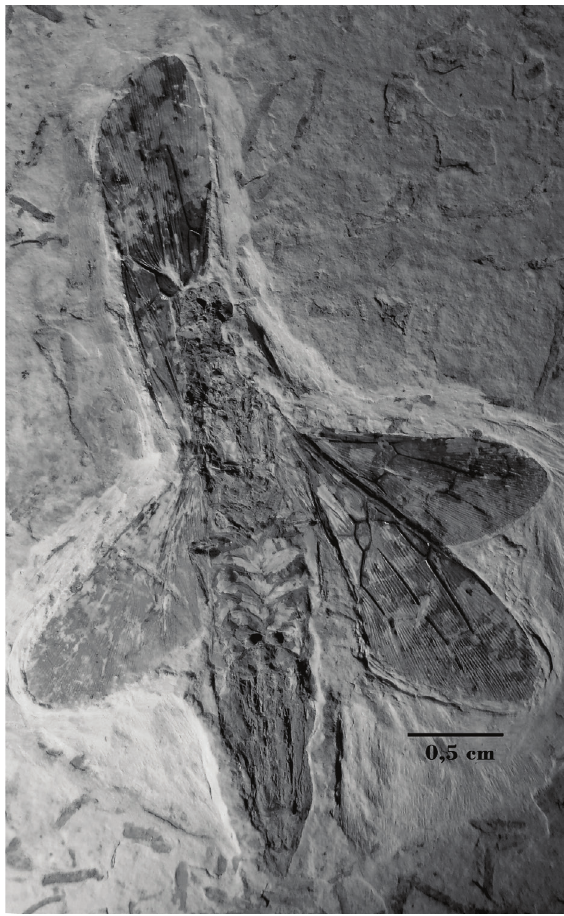
Figure 4. Myrmicium araripterum, sp. nov